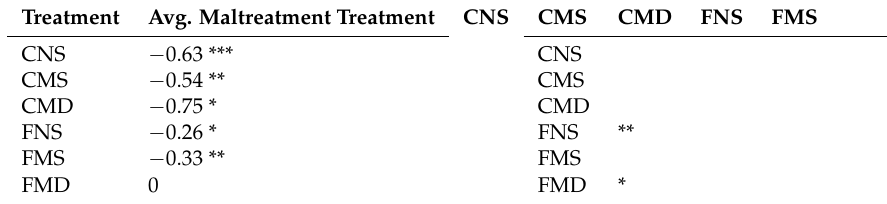
Table A9. Deviation from optimal treatment of Type H Patients across experimental conditions.